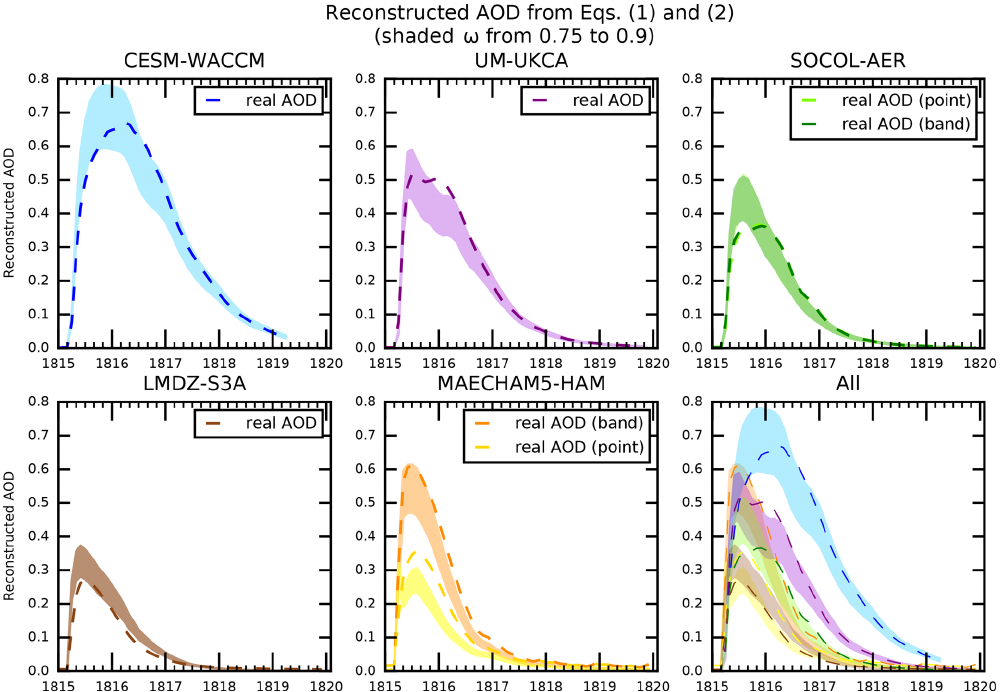
Figure 8. Reconstructed global stratospheric AOD time series using Eqs. (1) and (2). Shaded regions for each model are from ω = 0 . 9 (lower edge of shaded region) to 0.75 (upper edge of shaded region). The real AOD from each model is also shown (dashed lines). The dashed lines in this plot are equivalent to the lines in Fig. 1. For this plot, the corresponding values of ρ from ω used for Eq. (2) are calculated using the relationship described by Myhre et al. (2003). The light and dark green dashed lines (and shading) for the SOCOL-AER real (and reconstructed) AOD plot are indistinguishable from each other because the values from the point and band injections are